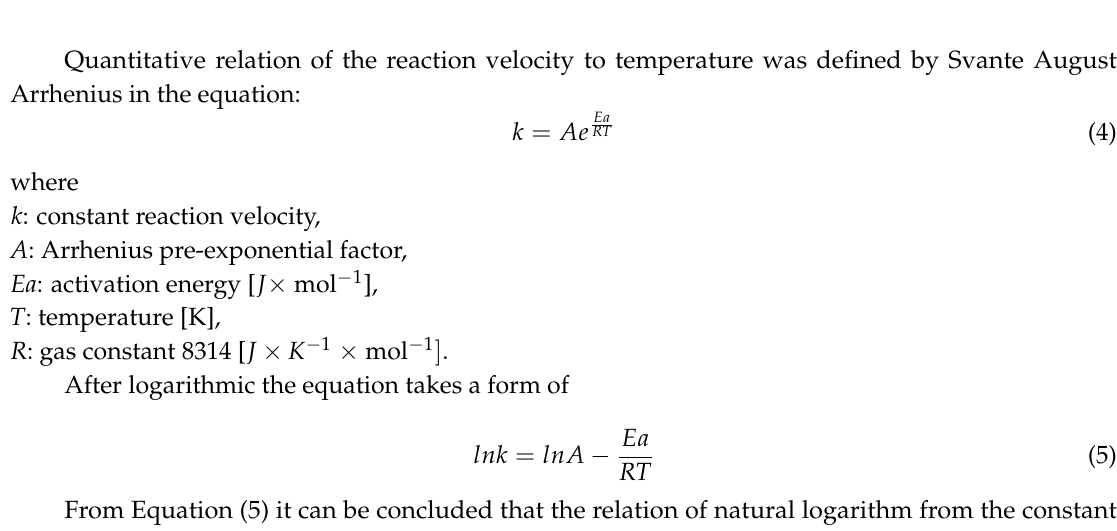
Figure 12. Natural logarithm relation of free chlorine concentration over time for different